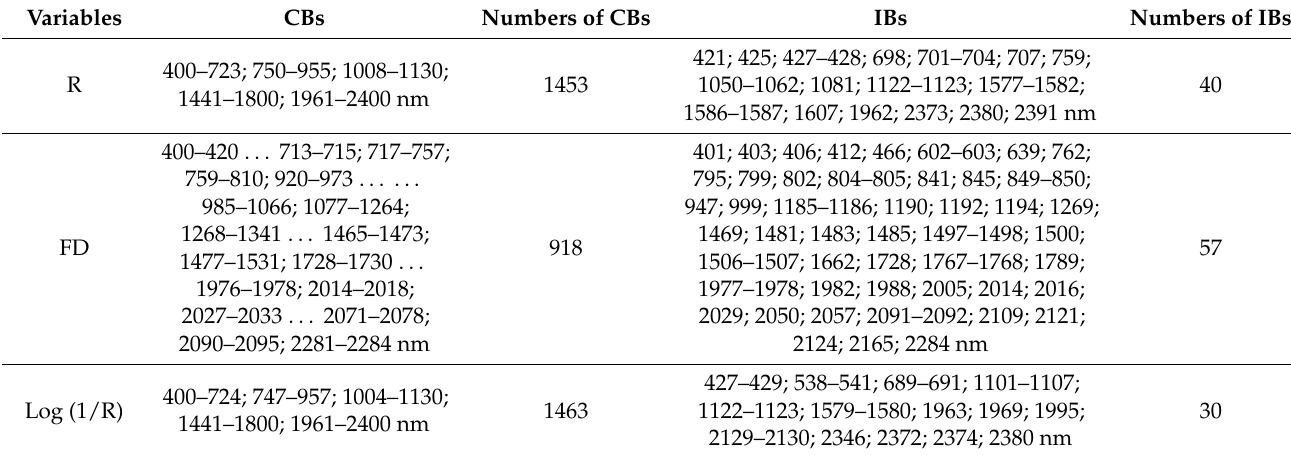
Table 4. Correlation bands and important bands selection using correlation analysis and GA-PLS, respectively.